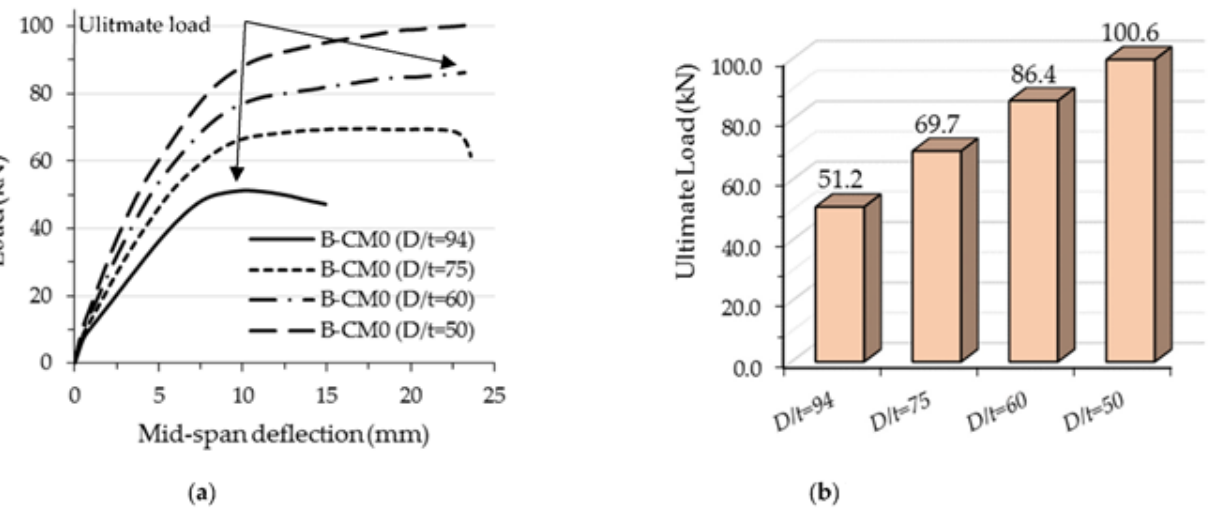
Figure 20. Comparison of the results of FE models with varied depth-to-thickness ratios ( D / t ): ( a ) Load-deflection relationship; ( b ) Ultimate load.